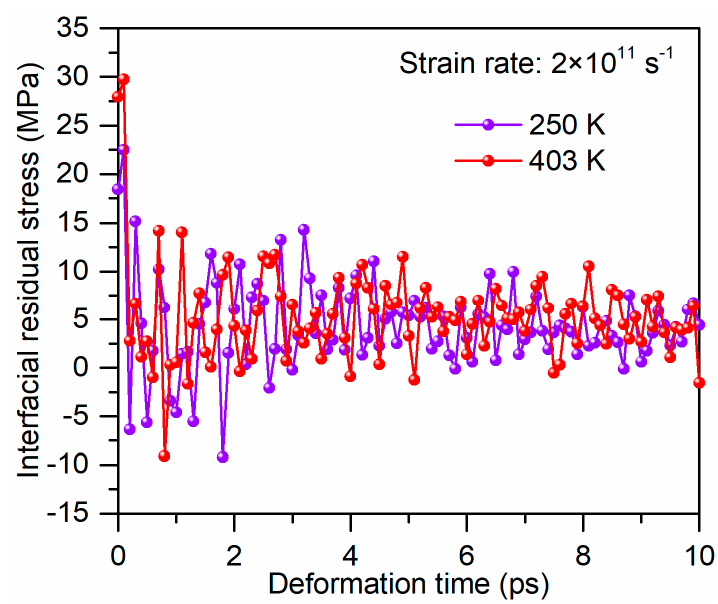
Figure 4. Tensile stress-strain curves of glass fiber/PP composites at different loading temperatures.